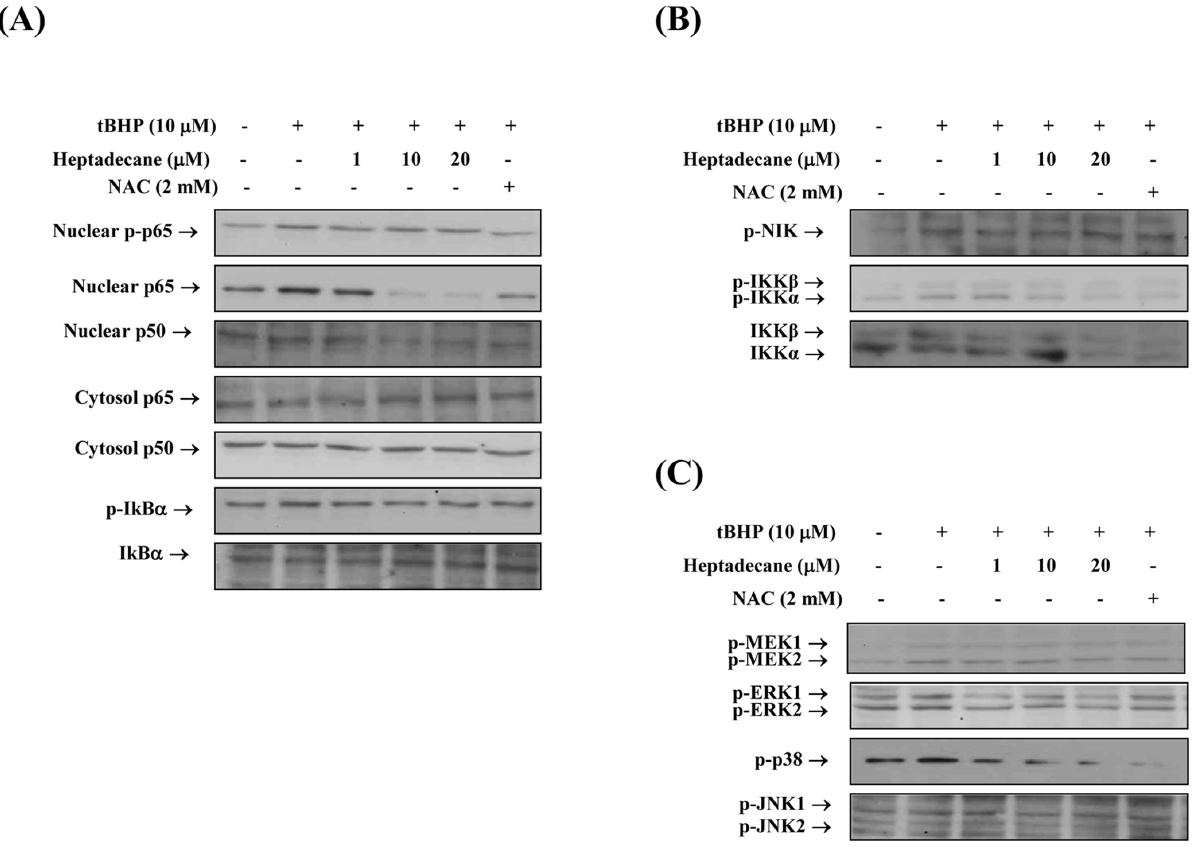
Figure 7. The regulation of NF-kB by heptadecane via NIK/IKK and MAPKs induced by oxidative stress. YPEN-1 cells were grown until 80% confluent in 100 mm dishes in DMEM medium. Cells were pre-treated (1 hr) with heptadecane (1, 10, or 20 m M) or NAC (2 mM), then stimulated with 10 m M t-BHP. (A) After stimulation with t-BHP (1 hr for NF-kB) in the absence (-) or presence ( + ) of heptadecane (1, 10, or 20 m M), cells lysed and total nuclear and cytosolic proteins were extracted. Western blot was performed for p50, p65 and I k B. (B) After stimulation with t-BHP (10 min for phosphorylated NIK and 20 min for phosphorylated IKK) in the absence (-) or presence ( + ) of heptadecane (1, 10 or 20 m M), cells were lysed and p-NIK and p-IKK a / b levels were determined. (C) After stimulation with t-BHP (10 min for phosphorylated MEK1/2 and 20 min for phosphorylated MAPKs) in the absence (-) or presence ( + ) of heptadecane (1, 10, or 20 m M), cells were lysed and p-MEK1/2, p-ERK1/2, p-p38, and p-JNK levels were determined. One representative experimental blot of each protein is shown from three experiments that yielded similar